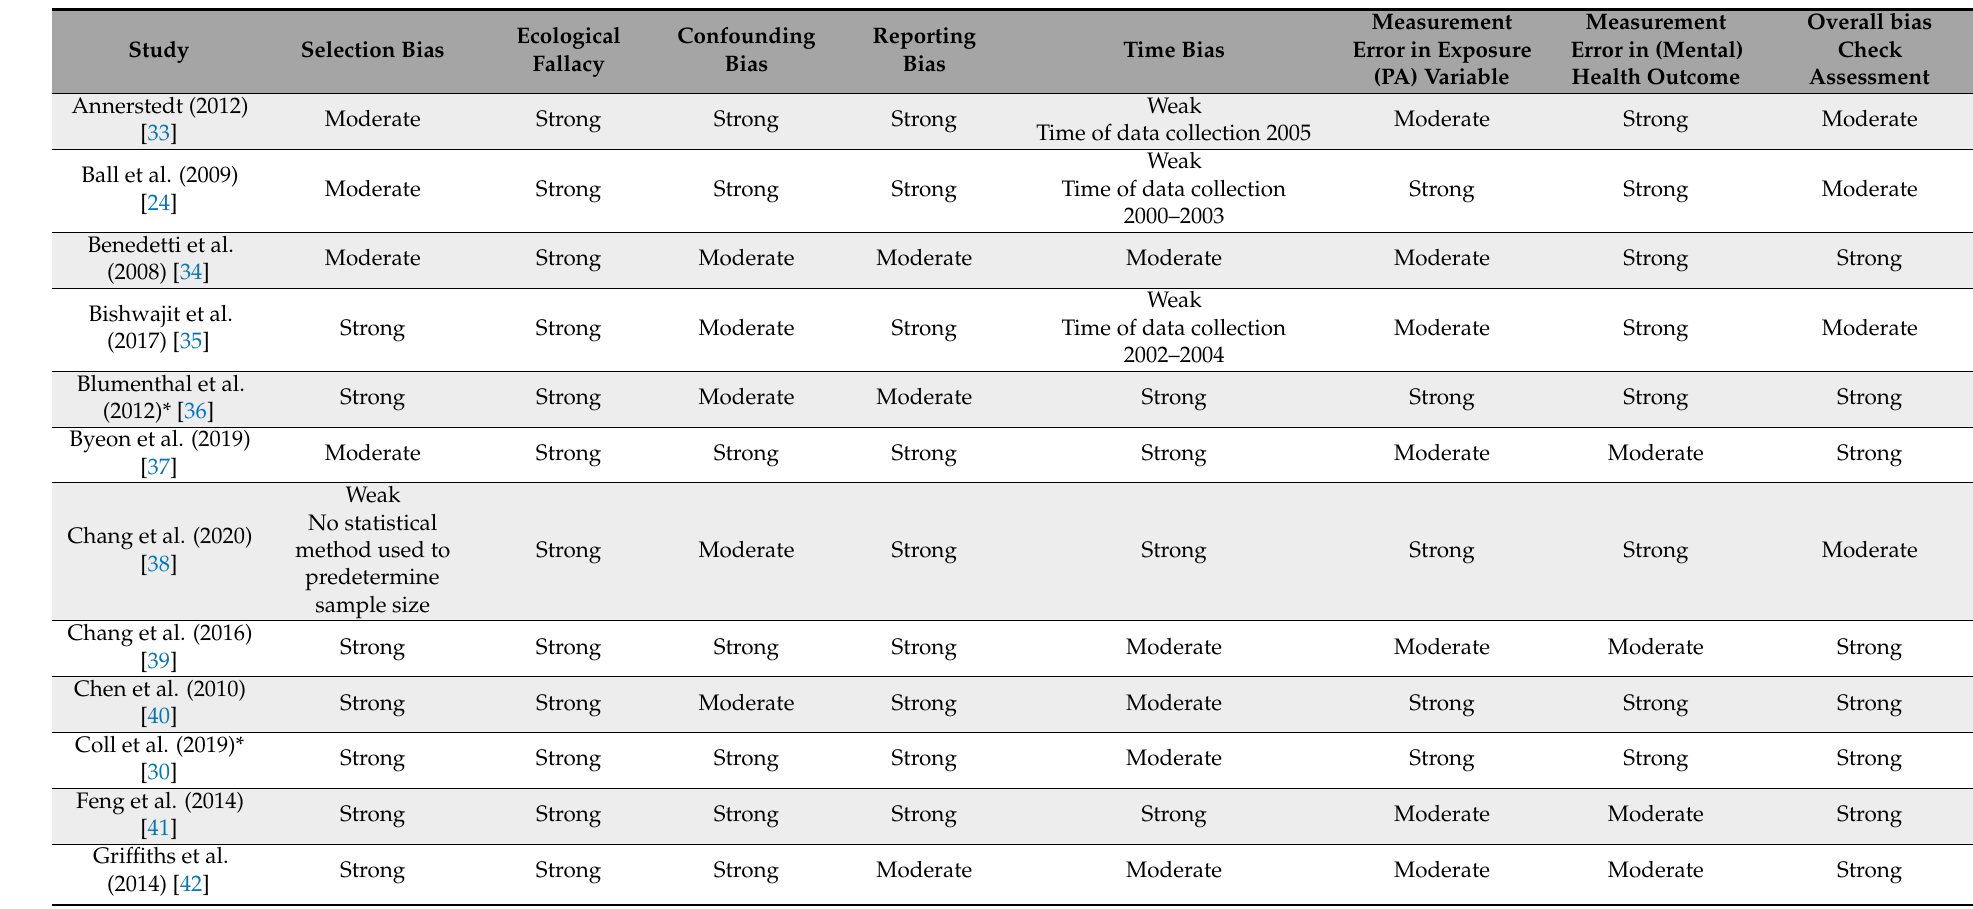
Table 2. Evaluation of studies according to Parmar et al. (2016) [29] Risk of Bias and quality